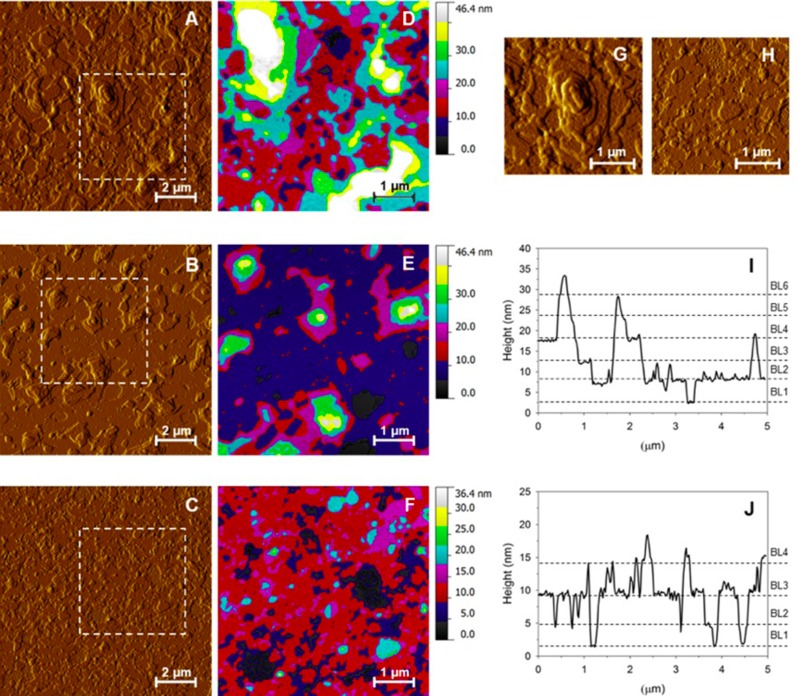
Representative atomic force microscopy amplitude images of Poractant alfa and Calsurf.Comparison of representative atomic force microscopy amplitude images of Poractant alfa at a phospholipid concentration of 80 mg/mL (A) and 35 mg/mL (B), and Calsurf at a concentration of 35 mg/mL (C). Selected regions of interest in A-C (squares delineated by white dashed lines) were color-coded in order to emphasize the height of overlapping phospholipid domains in D-F. The color switch was set every 5.5 nm for Poractant alfa (D-E) and 4.5 nm for Calsurf (F), based on the bilayer thickness measured for each surfactant preparation. In Calsurf, three overlapped homogeneous bilayers composed the bottom of the deposition and poor tridimensional complexity was detected. At a comparable phospholipid concentration, Poractant alfa showed peculiar multilamellar structures widespread above a multilayered ultrastructure. Dimensions of multilamellar structures increased with Poractant alfa concentration (maximum height greater than 100 nm). Detail of a lamellar body-like structure of Poractant alfa composed of 10 overlapped bilayers (G) and Calsurf ultrastructure (H). Dashed lines in (I) and (J) are height profiles marking each bilayer-bilayer (BL) transition in overlapped surfactant structure in Poractant alfa and Calsurf.